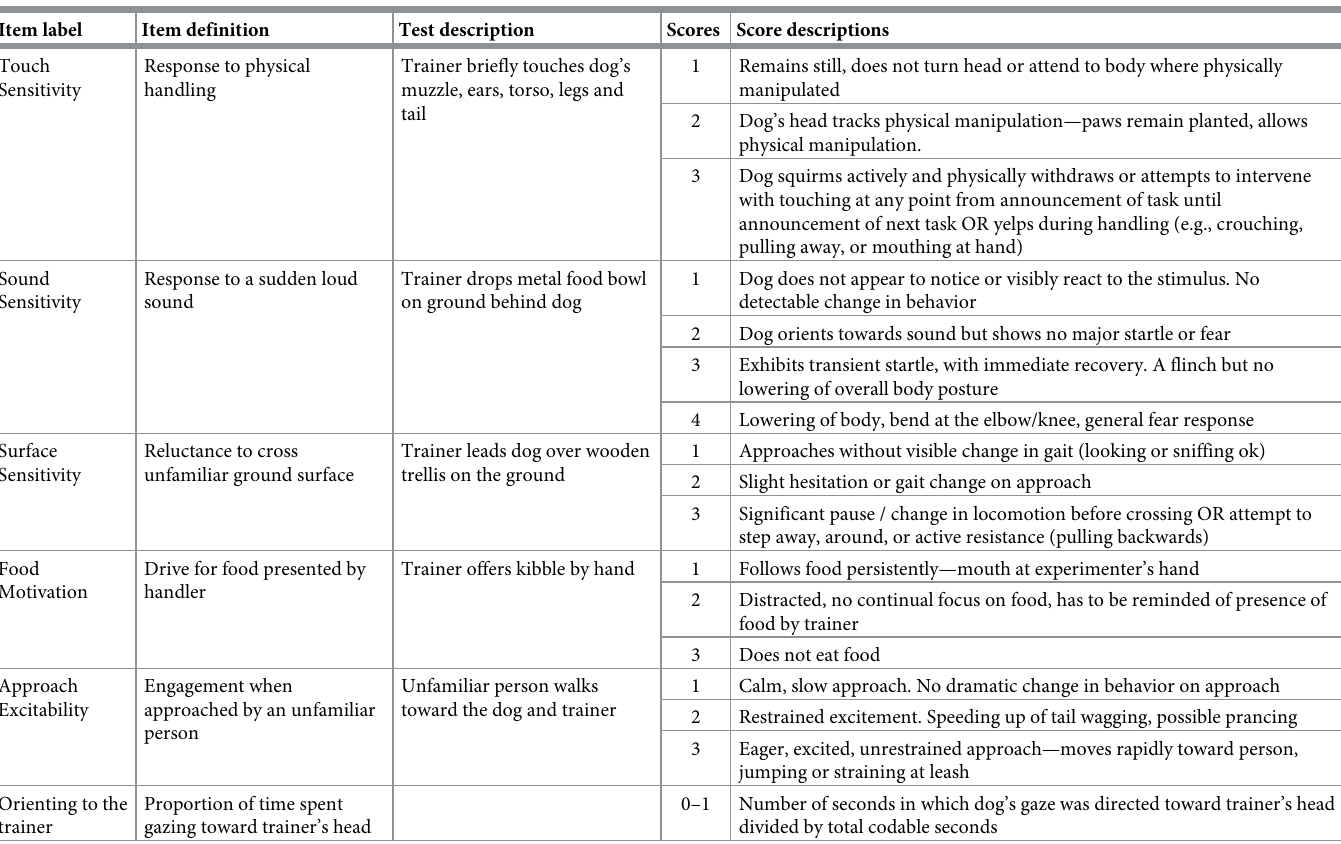
Table 1. Ethogram of behaviors scored from service dog temperament